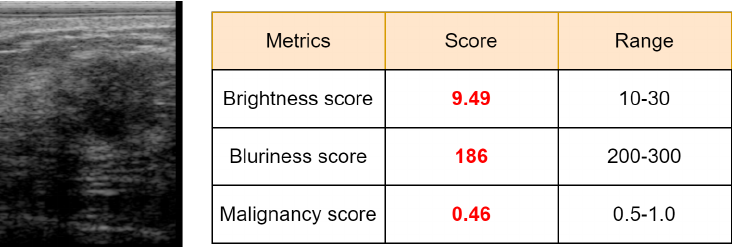
Figure 11. Visualization of activation maps using Grad-CAM for ( a , b ) benign, and ( c , d ) malignant cases.